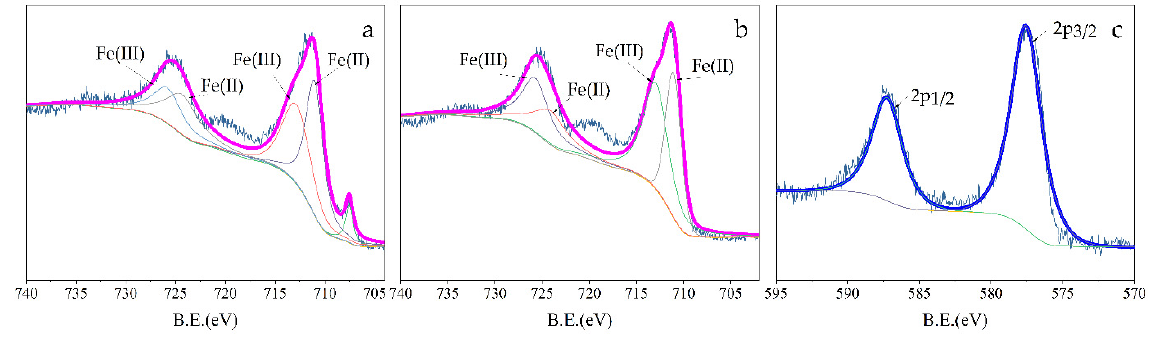
Figure 7. High-resolution XPS spectrum of Fe2p and Cr2p: ( a ) nZVI/rGO, ( b ) nZVI/rGO after reaction, and ( c ) Cr2p after reaction.